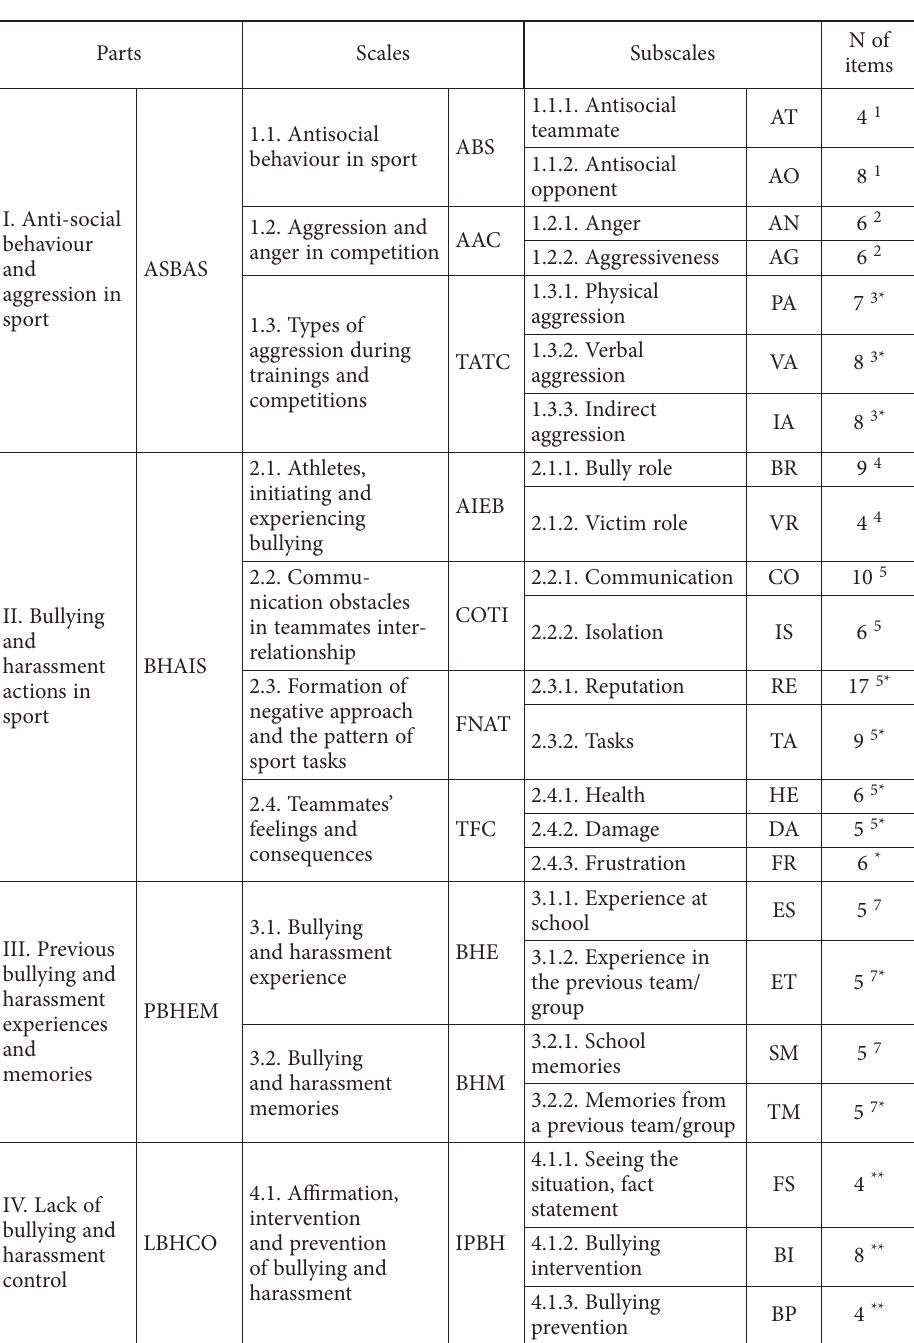
Table 1. Structure of the Bullying and harassment in sport questionnaire (BHISQ) (source: Vveinhardt & Fominienė, 2020b) Parts Scales Subscales